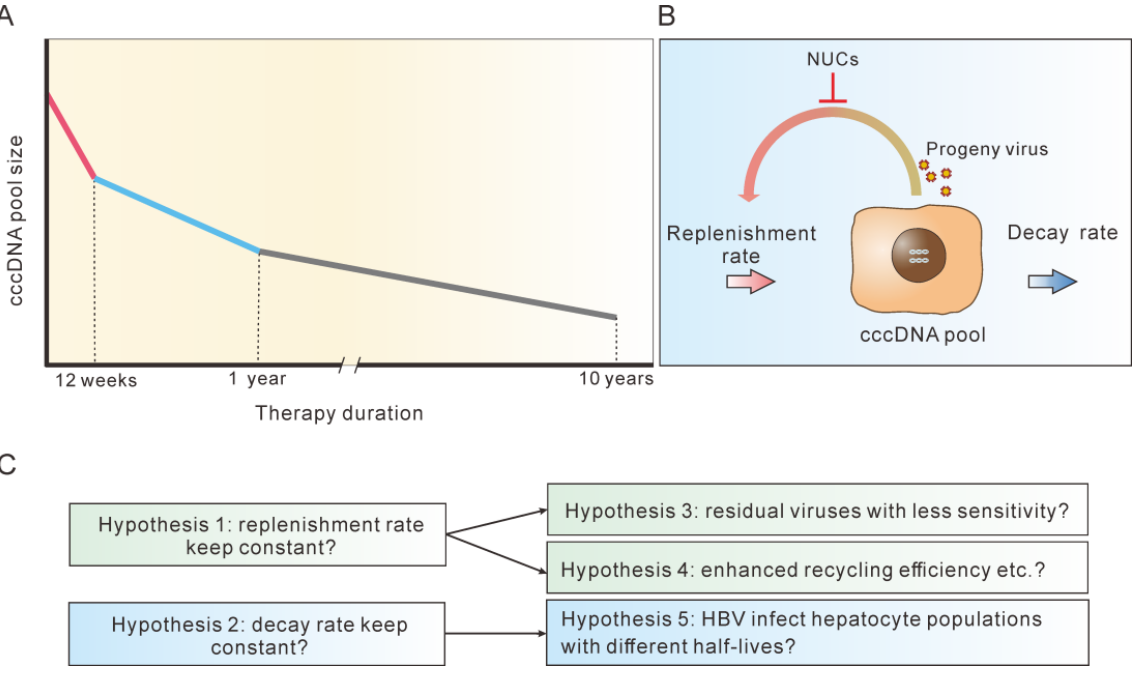
Figure 4. Explanations for the multi-phasic decline of cccDNA during long-term NUC therapy. ( A ) cccDNA declined in a multi-phasic model during long-term NUC therapy ([70], Tables 1 and 2). ( B ) NUC shifts the balance of the cccDNA pool by reducing replenishment. ( C ) There are several hypotheses for the multi-phasic decline of cccDNA during long-term NUC